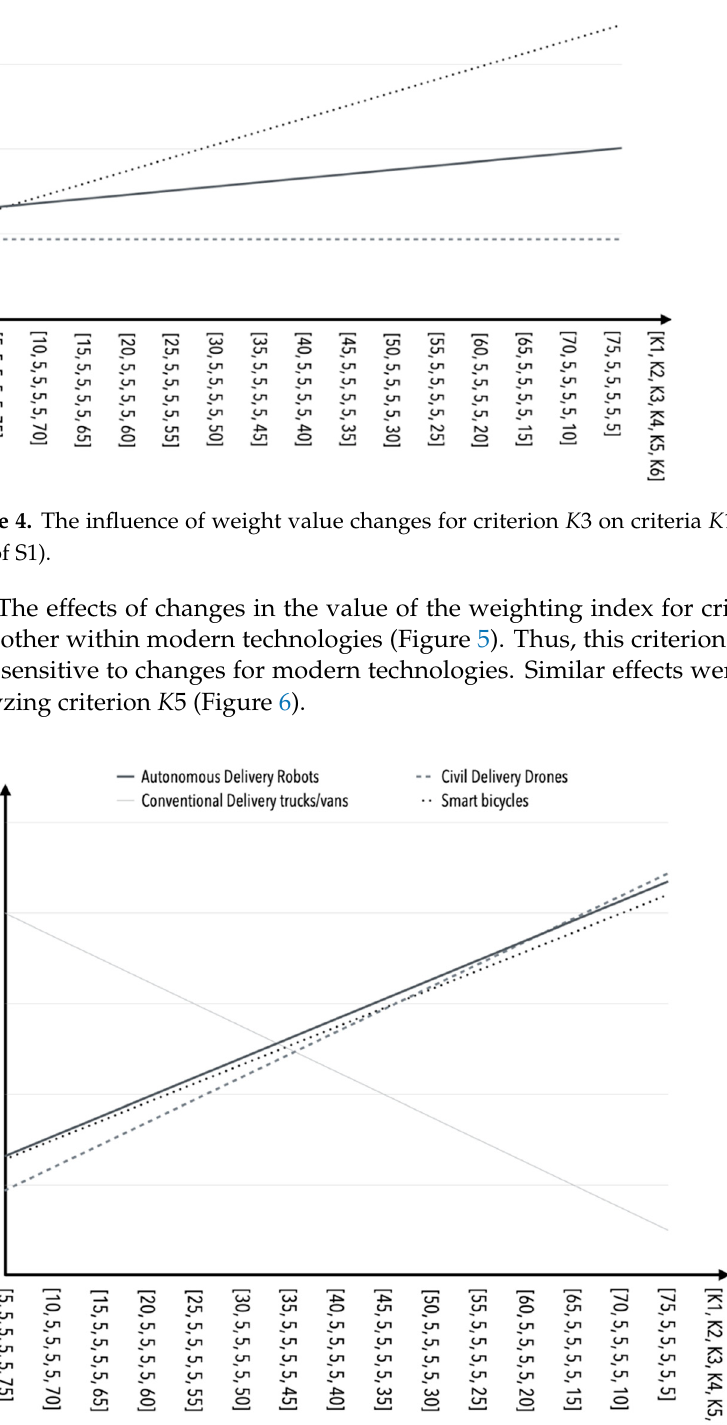
Figure 6. The influence of weight value changes for criterion K 5 on criteria K 1 –K 4 (in the case of S1). The MCDA model’s findings made it abundantly evident that contemporary solu- tions are superior to those that are already in use. Using smart bicycles or civil drones in settings of this type would be the most proper choice, according to the analysis and crite- rion function of the investigated scenario S1. With a slight difference in overall score,